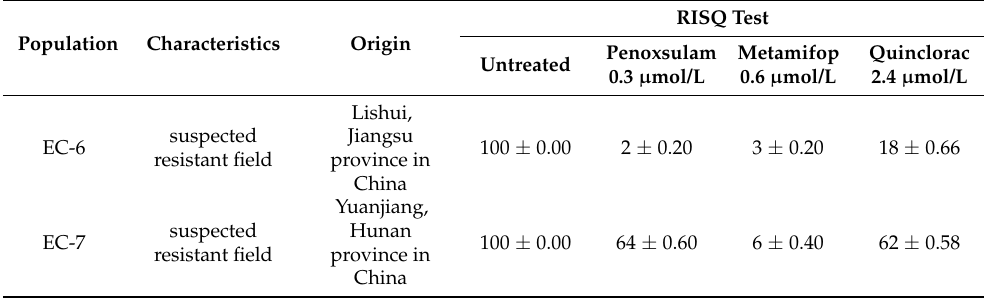
Table 8. The field samples and percentage surviving under discriminative rates of penoxsulam, metamifop, and quinclorac in the RISQ